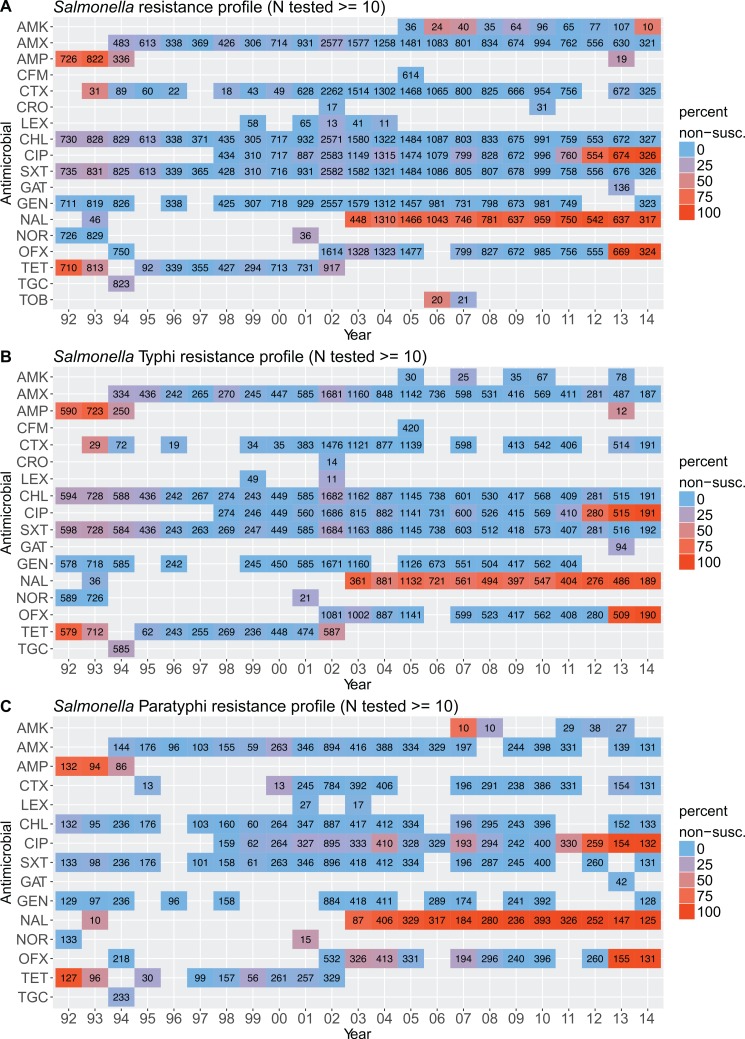
The antimicrobial susceptibility profiles of isolated Salmonella from 1992 to 2014. Plots summarising antimicrobial susceptibility data for all Salmonella (A), S. Typhi only (B), and S. Paratyphi only (C) from 1992 to 2014. The colour range on the heat map tiles indicate the proportion of non-susceptible isolates (blue, low; red; high), the number of isolates tested is indicated on the respective tile. Tiles with fewer than 10 isolates tested for the respective antimicrobial are not shown.